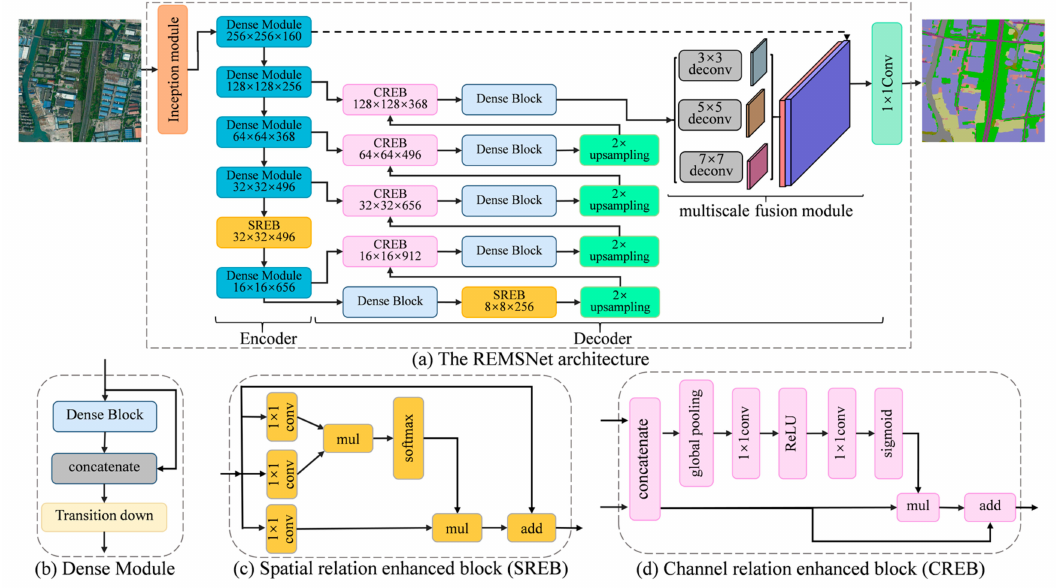
Figure 1. Relation-enhanced multiscale convolutional network (REMSNet)